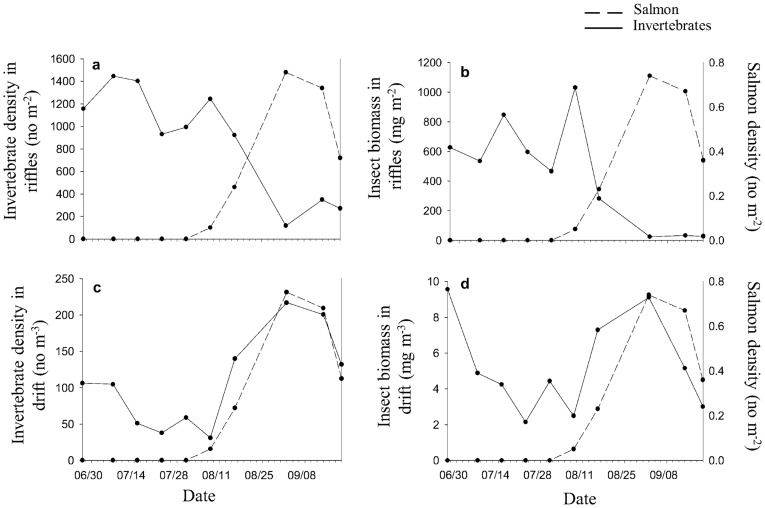
Invertebrates in riffles and drift throughout the salmon run.Invertebrate density (a) and insect biomass (b) in riffles, and invertebrate density (c) and insect biomass (d) in drift plotted against salmon density (right-hand axis). Note the differences in scale on the y-axis in all figures.